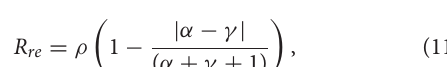
score R re , given